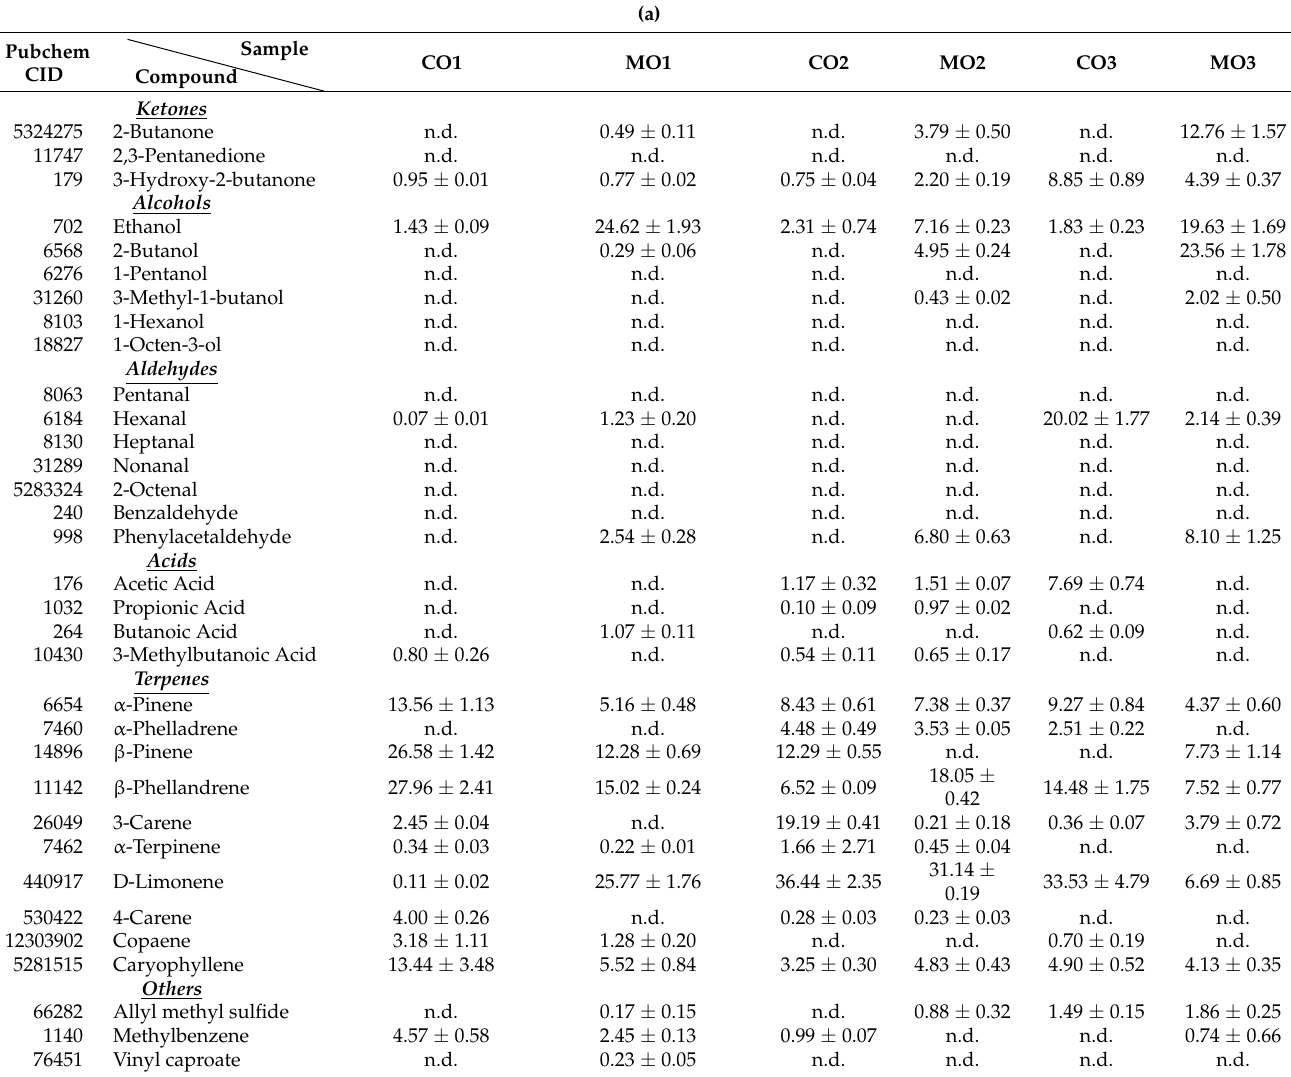
Table 4. ( a ) Volatile compounds (relative area % and standard deviations) detected in conventional (CO1, CO2, and CO3,) and Mora Romagnola (MO1, MO2, and MO3) samples. Compounds are listed by chemical classes. Samples were coded as CO1 (conventional salami with small size), MO1 (Mora Romagnola salami with the same size as CO1), CO2 (conventional salami of “Nostrano” type), MO2 (Mora Romagnola salami similar to CO2), CO3 (conventional salami of “Cacciatore” type) and MO3 (Mora Romagnola salami similar to CO3). ( b ) Volatile compounds (relative area % and standard deviations) detected in conventional (CO4 and CO5), Mora Romagnola (MO4 and MO5), and CON, FEL, and MIL salami samples. Compounds are listed by chemical classes. Samples were coded as CO4 (conventional salami obtained directly from a local producer), MO4 (Mora Romagnola salami similar to CO4), CO5 (conventional salami obtained directly from a local producer), MO5 (Mora Romagnola salami similar to CO5), CON (conventional salami of “Contadino” type), FEL (conventional salami of “Felino” (PGI) type), and MIL (conventional salami of “Milano” type).